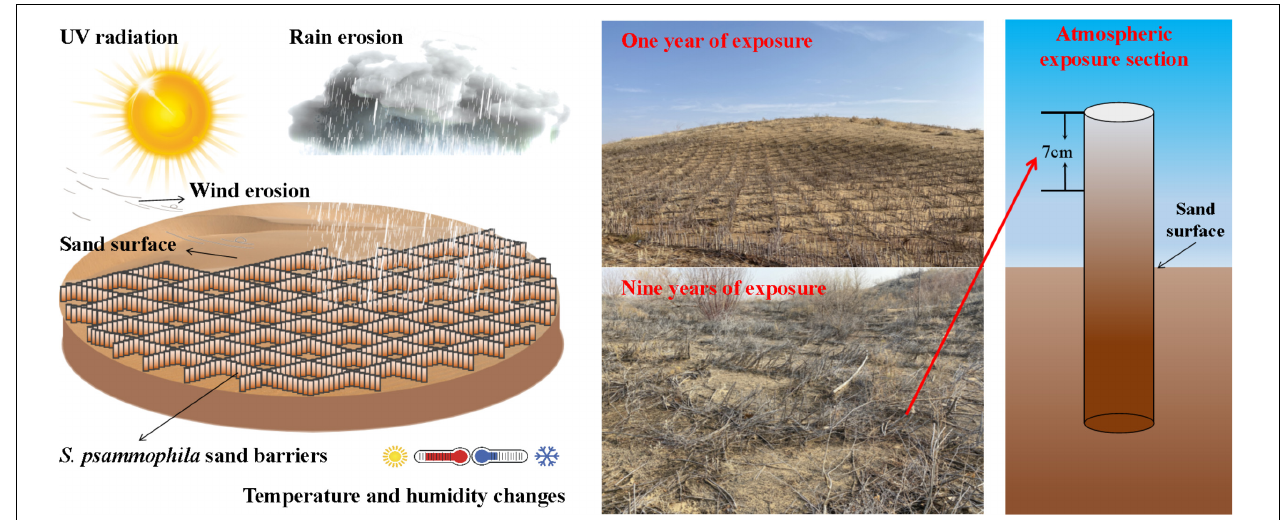
FIGURE 1 | Schematic diagram of the Salix psammophila sand barrier sample in atmosphere exposed